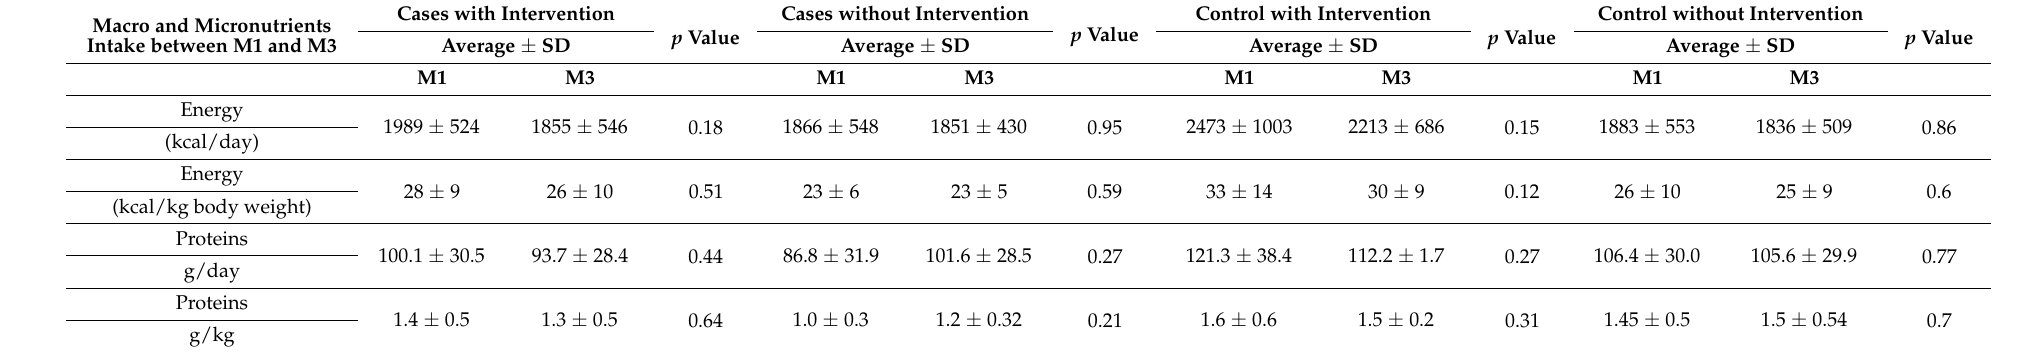
Table 4. Macro and micronutrients intake between first nutrition appointment (M1) and final evaluation after two months (M3) of different